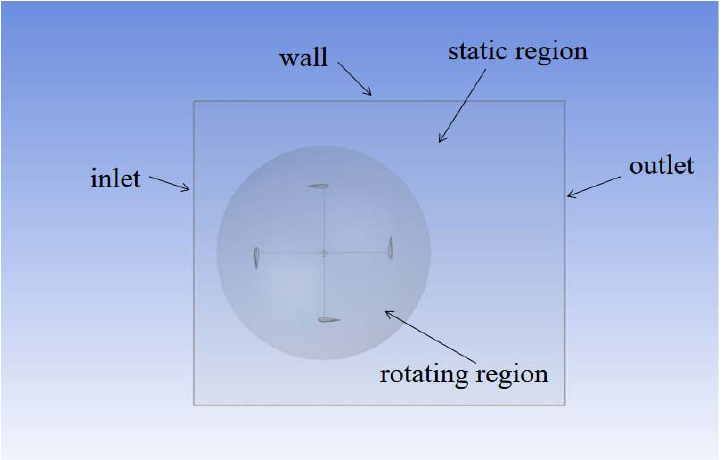
Figure 2. Drainage basin setting diagram.